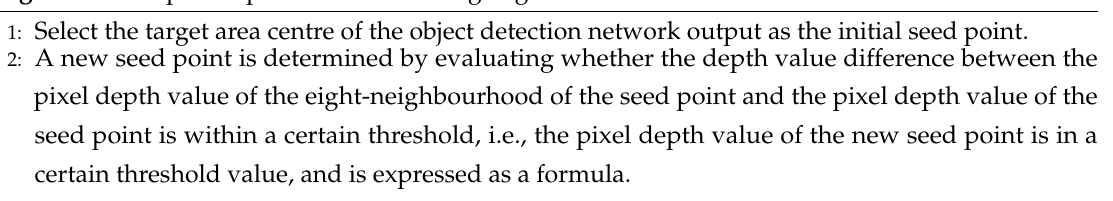
Algorithm 1 Depth Map-Based Flood Filling